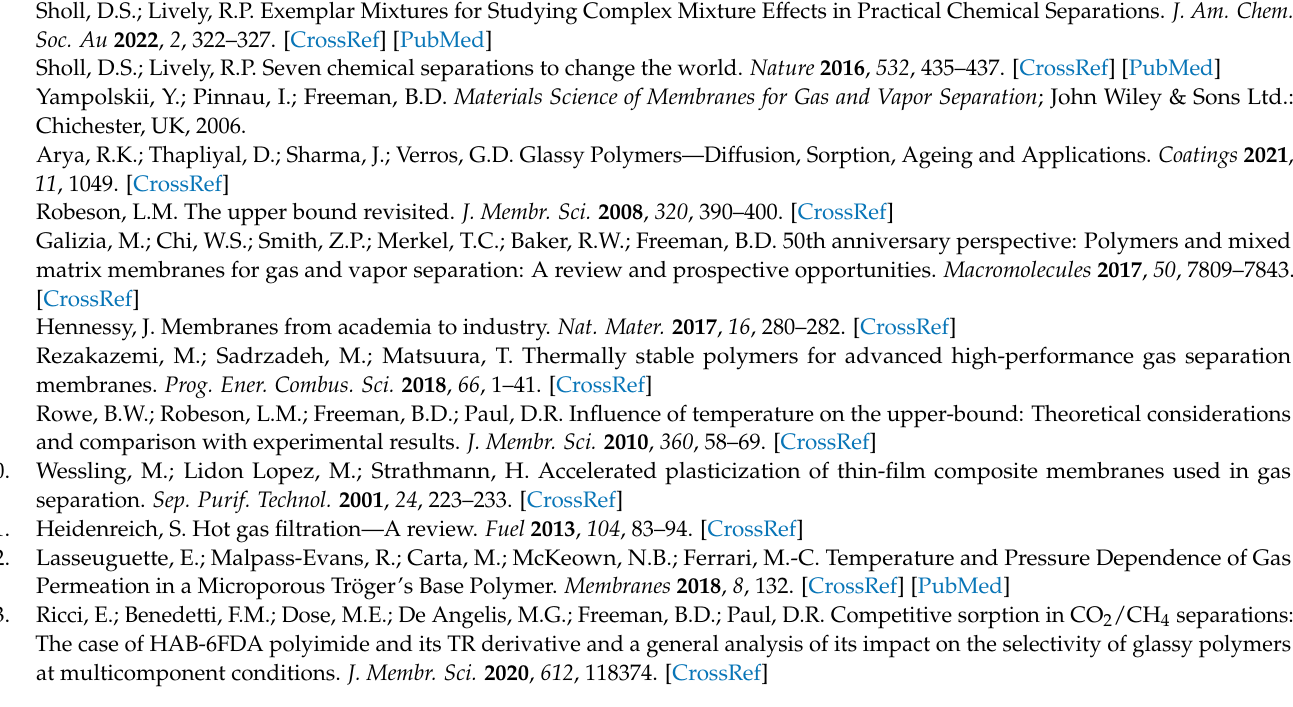
Figure S2: partial charges for all OAPS-based networks; Figure S3: radial distribution functions in the mixtures; Figure S4: variations in the number of sorbed CO 2 at 60 bar predicted by GCMC for successive configurations at 300 ◦ C; Figure S5: typical interOAPS-imide and intraOAPS-imide links. Figure S6: probability density distributions for the number of arms linked per cage in the networks. Table S1: atom-types for all OAPS-based molecules; Table S2: force-field parameters for the bonds, bending and out-of-plane potentials; Table S3: force-field parameters for the torsional and van der Waals potentials; Table S4: concentrations and solubilities of the gases in the pure gas phase at 300 ◦ C and 400 ◦ C and at a pressure of 60 bar; Table S5: concentrations and solubilities of the binary mixtures in the mixed-gas phase at 300 ◦ C and 400 ◦ C and at a pressure of 60